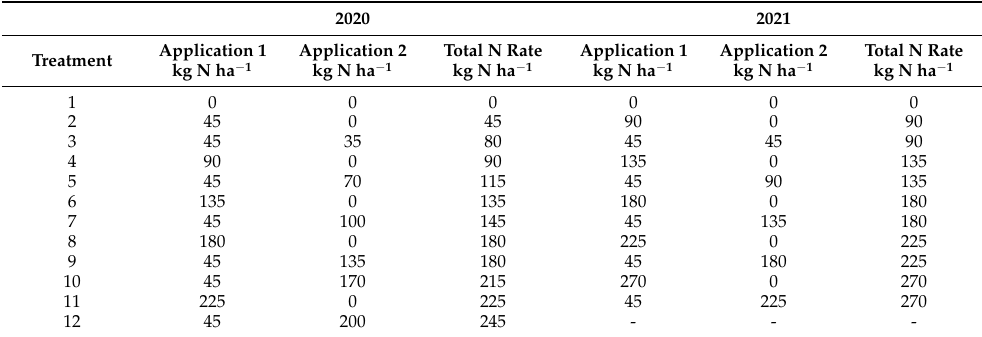
Table 2. Treatments, first and second application rates, and total N rates applied at Brooksville, Starkville, Stoneville, and Verona, MS in 2020 and